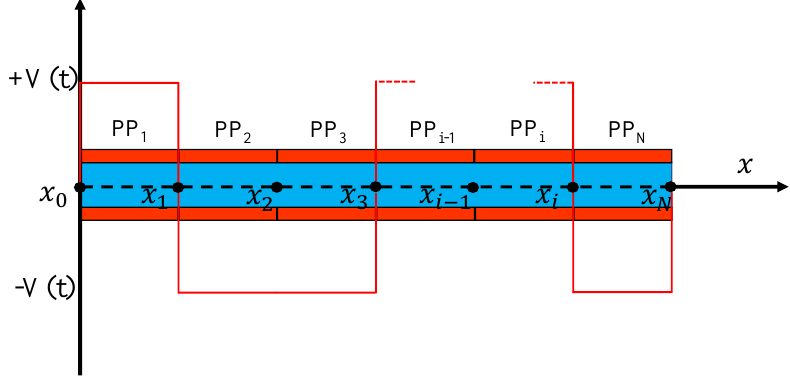
Figure 3. Example of a voltage distribution on the